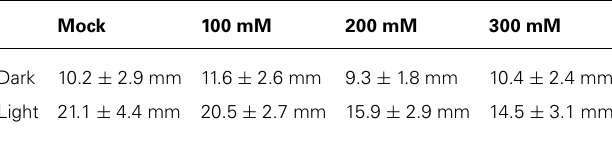
Table 2 | Arabidopsis root lengths in different salt and light